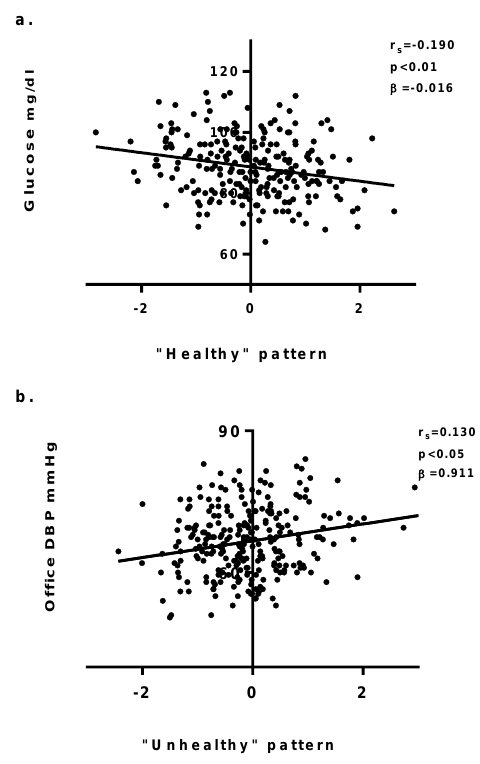
Figure 4. ( a–b ) Associations between “healthy pattern” and capillary glucose level ( a ) and between Figure 4. (a–b). Associations between “healthy pattern” and capillary glucose level (a.) and between “unhealthy pattern” brachial diastolic blood pressure ( b ) DBP: diastolic blood “unhealthy pattern” brachial diastolic blood pressure (b). DBP: diastolic blood pressure.